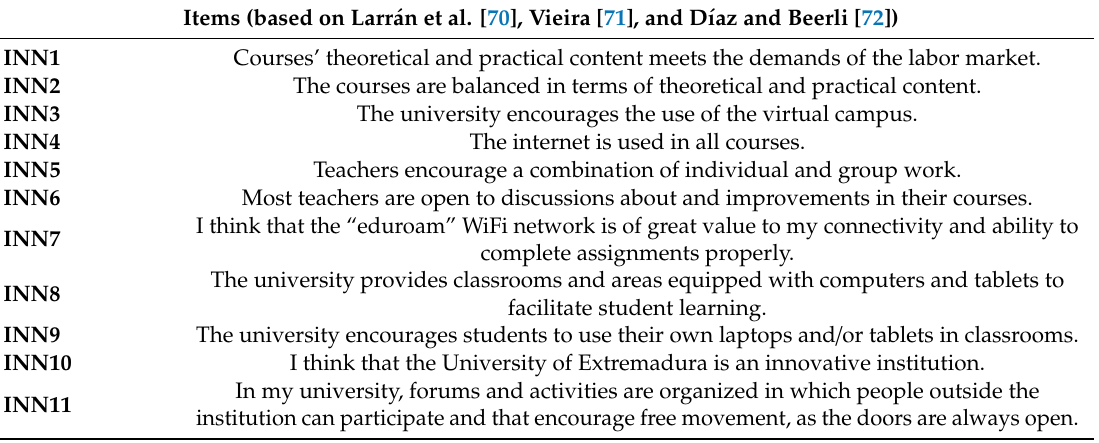
Table A1. Indicators of Perceived